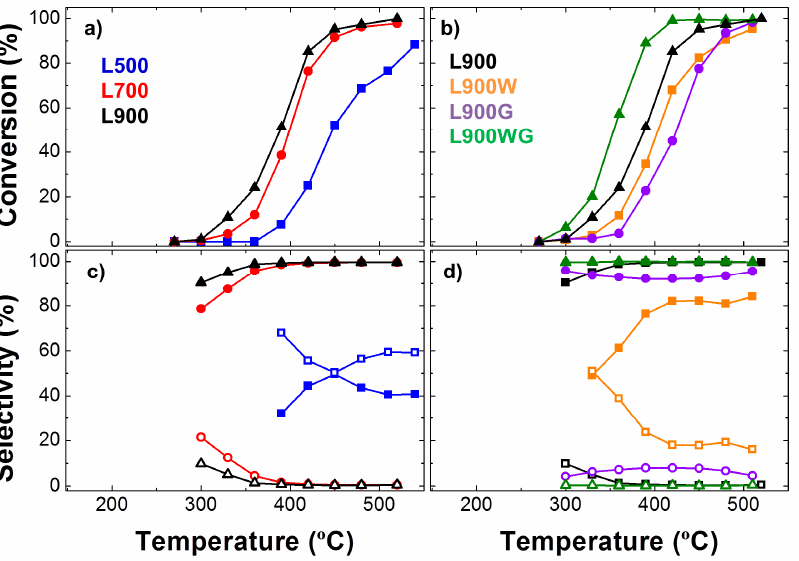
Figure 6. Evolution of the steady-state conversions of 2-propanol ( a , b ) and selectivity to acetone (filled marks) and propylene (hollow marks) with the temperature ( c , d ) for all the carbon catalysts in a helium flow (Po ALC = 0.0185 atm; W/Fo ALC = 0.073 g s μ mol − 1 ).